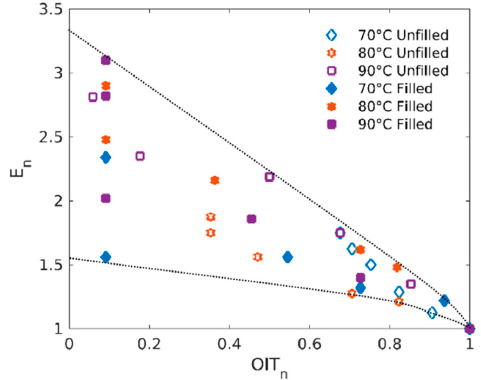
Figure 5. Normalized modulus E n as a function of normalized oxidation induction time OIT n .